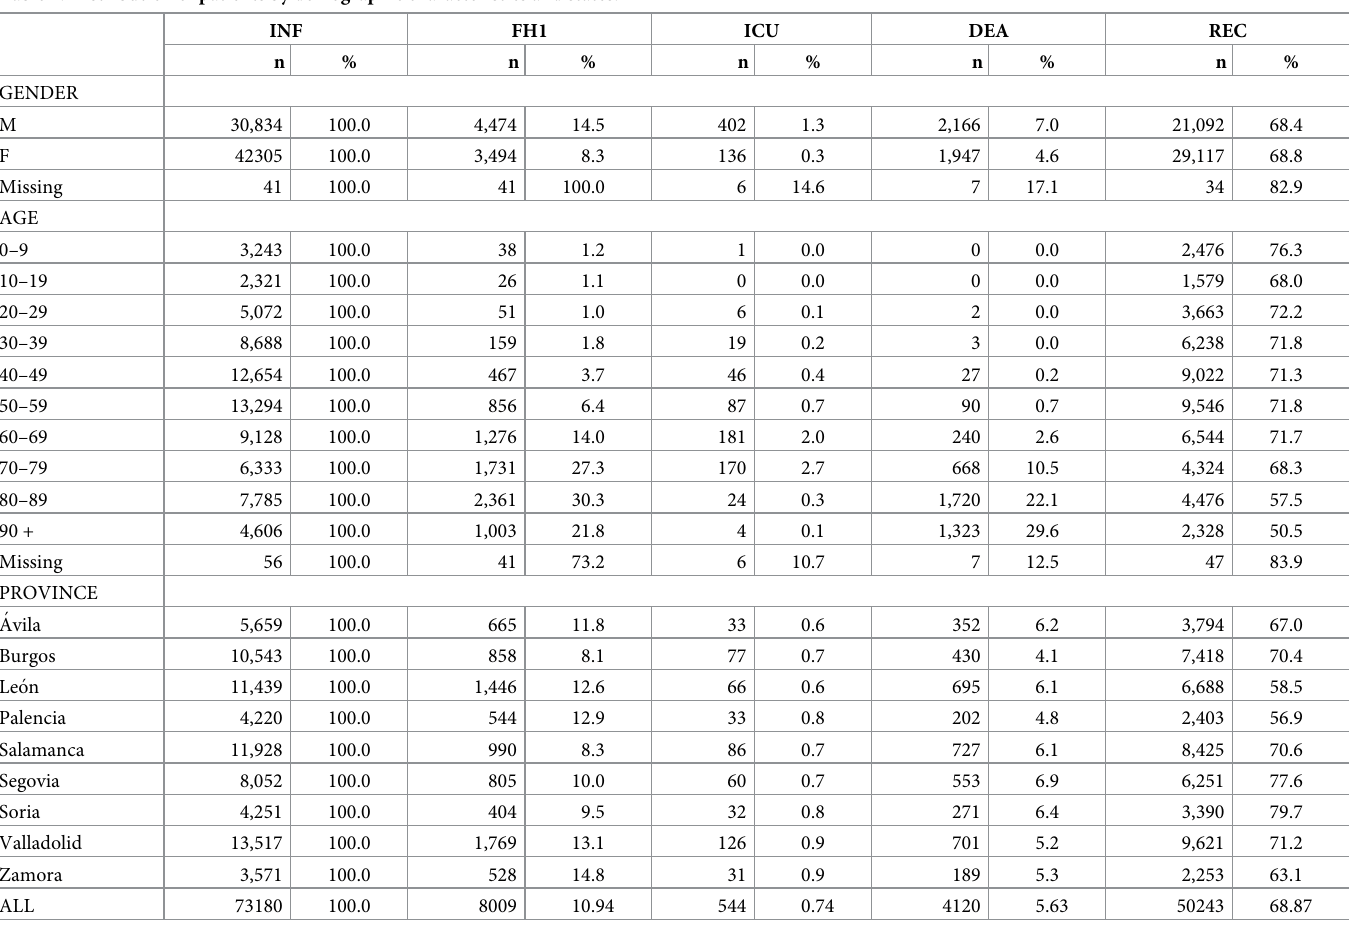
Table 1. Distribution of patients by demographic characteristics and